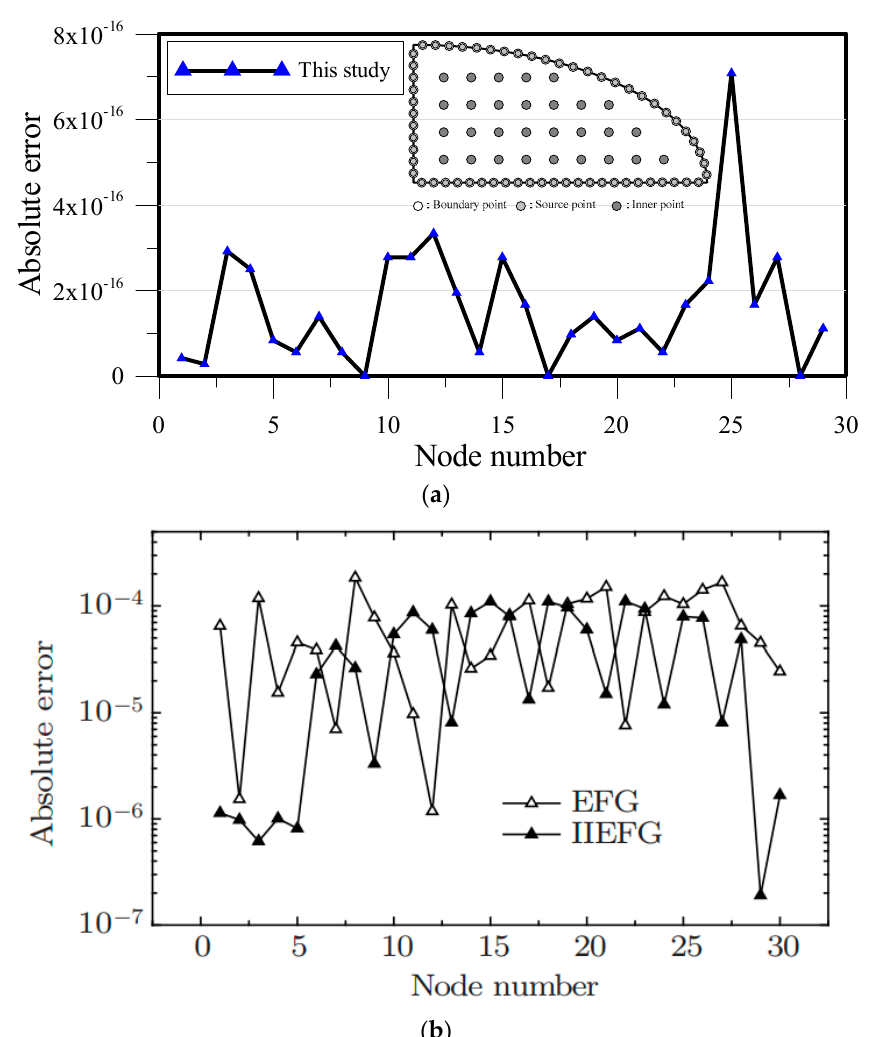
Figure 4. Comparison of computed results of the proposed method. ( a ) Comparison of results with the analytical solution and ( b ) comparison of results with the EFG and the IIEFG methods.